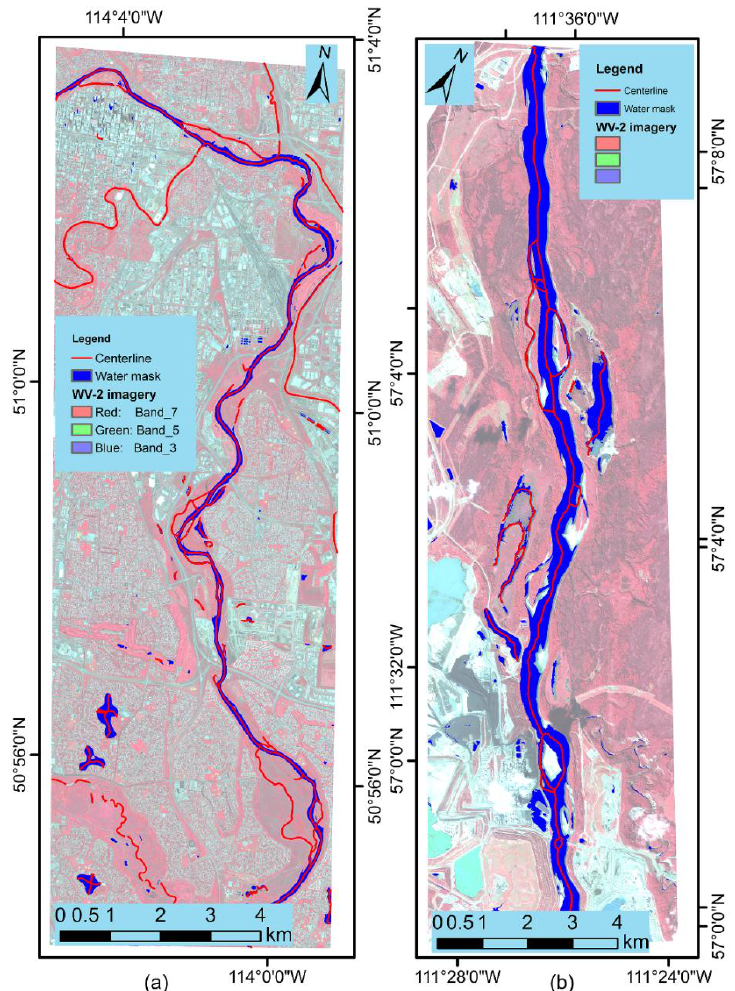
Figure 13. Final water masks and river centerlines for ( a ) the Bow River site and ( b ) the Athabasca River site. The background is the false colour optical images using WV-2 bands. The final mask (blue colour patches) and the river centerlines (red lines) are draped over the